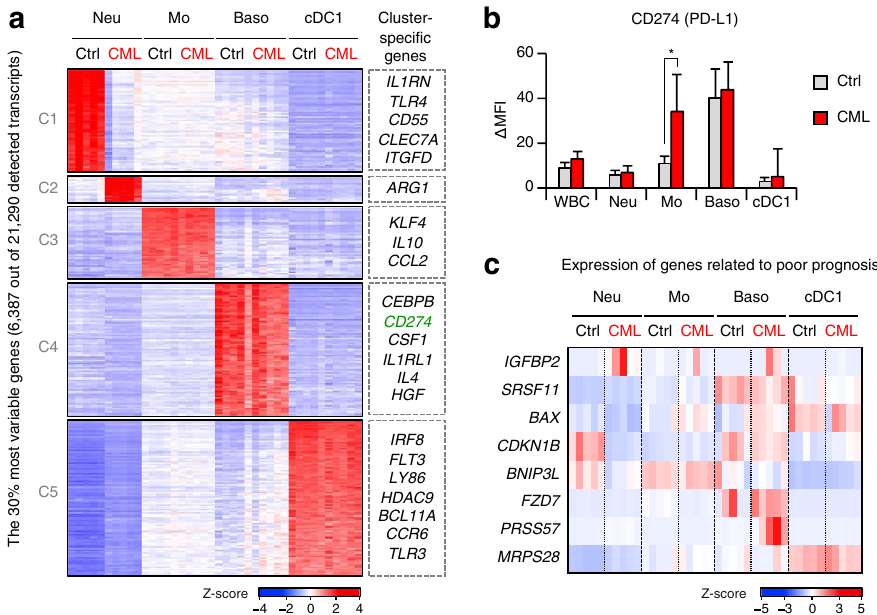
Figure 5. Identification of myeloid cell populations with gene expression patterns that are related to poor prognosis in CML patients. ( a ) Heat map of the top 30% differentially expressed genes among indicated myeloid cell populations from healthy controls [Ctrl] and CML patients [CML]. Gene clusters (1 to 5) were defined according to K-means clustering. Neu, neutrophils; Mo, monocytes; Baso, basophils; cDC1, type 1 conventional dendritic cells. ( b ) Protein expression levels of PD-L1 in myeloid cells of healthy controls [Ctrl] (n = 6) and CML patients [CML] (n = 14). WBC, while blood cells. Values are the mean ± SD. * P < 0.05 (Student’s t -test). ( c ) Heat map showing expression levels of genes related to poor prognosis in indicated myeloid cell populations from healthy controls [Ctrl] and CML patients